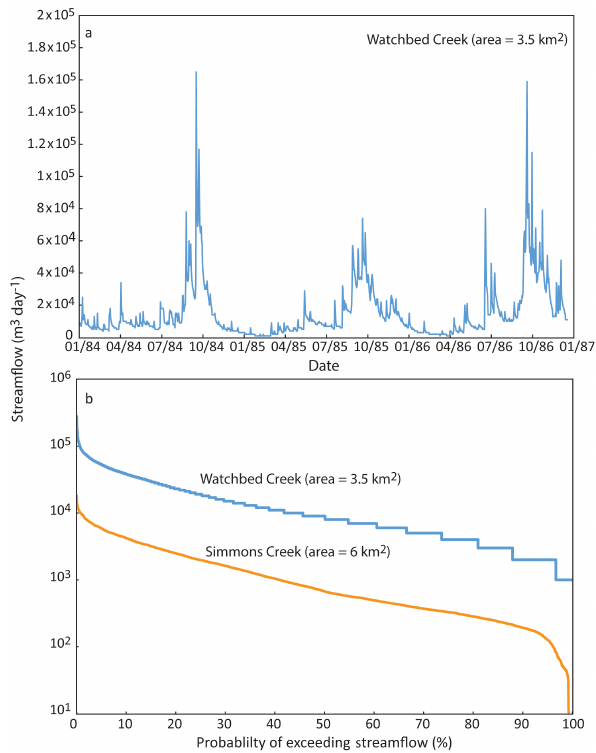
Figure 2. (a) Streamflow at Watchbed Creek, which drains peat- lands at Falls Creek (Fig. 1), between 1984 and 1987. (b) Flow dura- tion curves for Watchbed Creek and Simmons Creek, which drains the eucalyptus forest in the Upper Ovens (Fig. 1). Data are from the Department of Environment, Land, Water and Planning